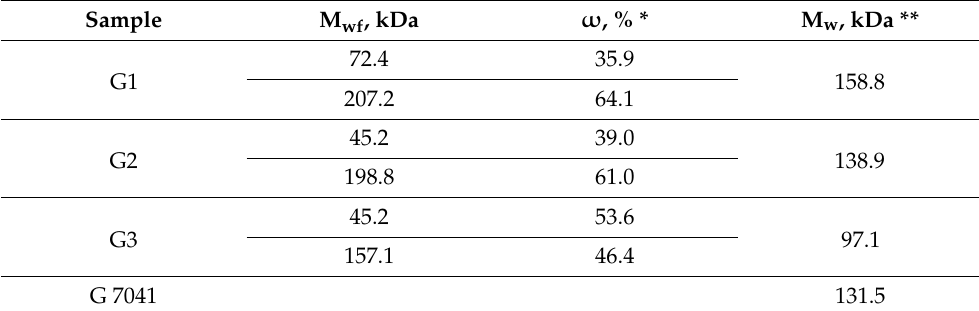
Table 4. Molecular weight distributions of gelatin samples obtained by HPLC.